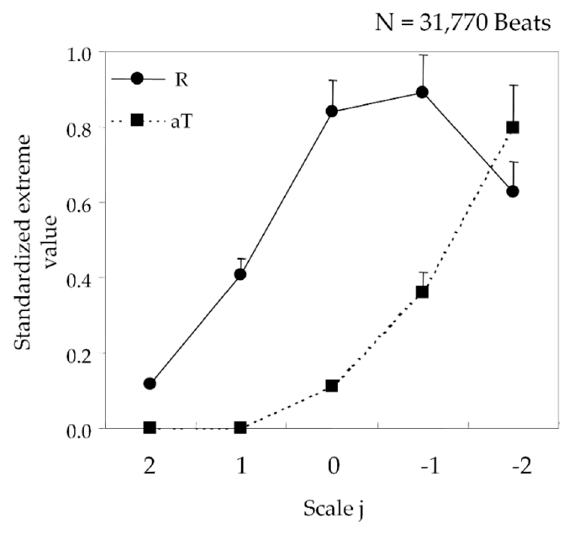
Figure 2. Changes in the features of R and aT for 12 subjects.